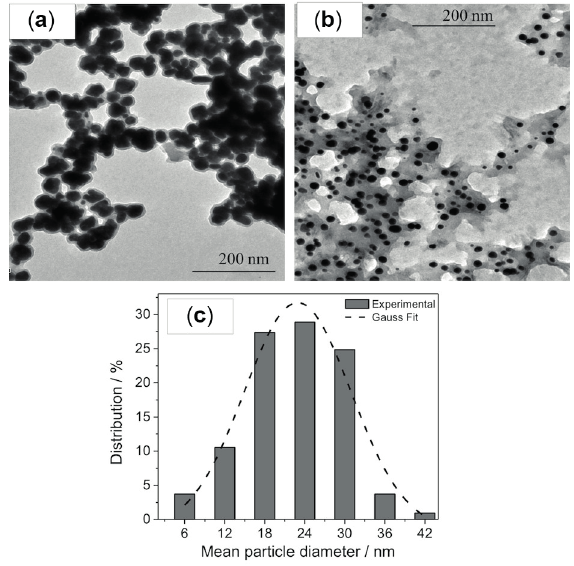
Figure 3 - TEM images for ( a ) AgNPs-TA, ( b ) AuNPs-TA and ( c ) size distribution histogram obtained from TEM images (322 nanoparticles) of AuNPs-TA, showing their